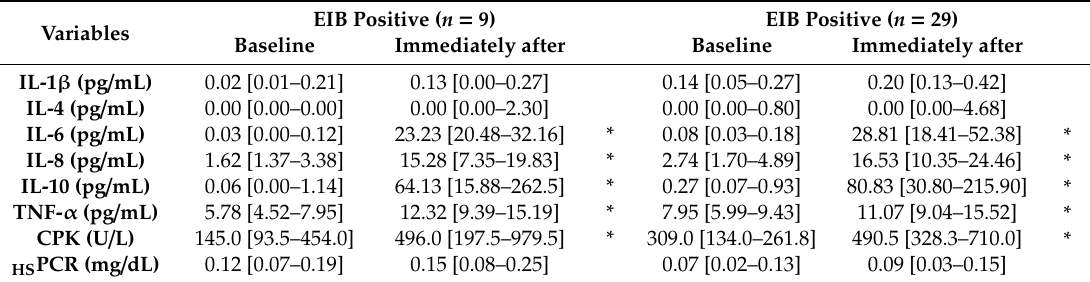
Table 3. Comparison of blood inflammatory markers before and after the race and between groups—International Marathon of